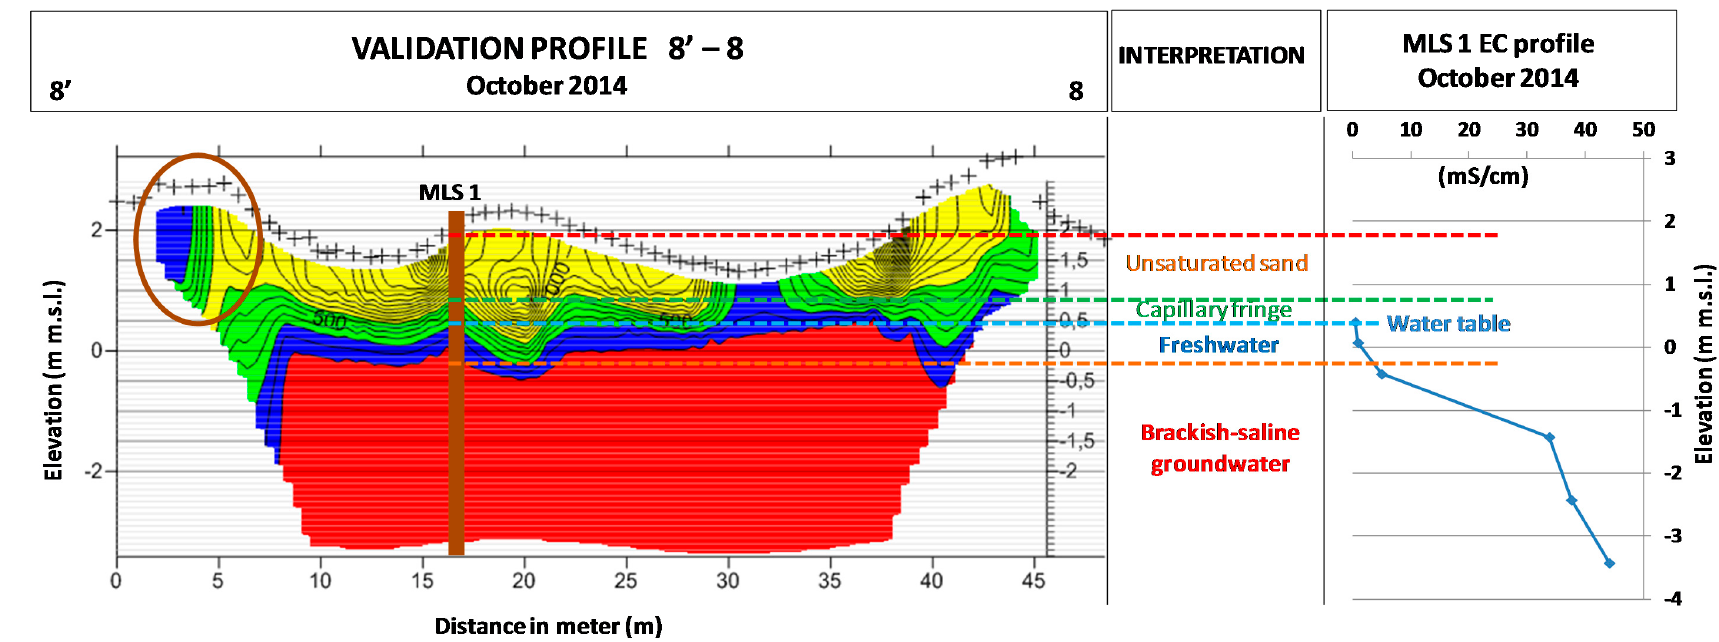
Figure 5. Subsurface model of profile 8’-8 where the four hydrogeological units are identified by different colors. The vertical log of groundwater EC data at MLS1 is shown on the right side of the figure (WTD is marked by the dashed light-blue line). Note that the brown-color circle indicates an abrupt change in resistivity due to the unpaved road.